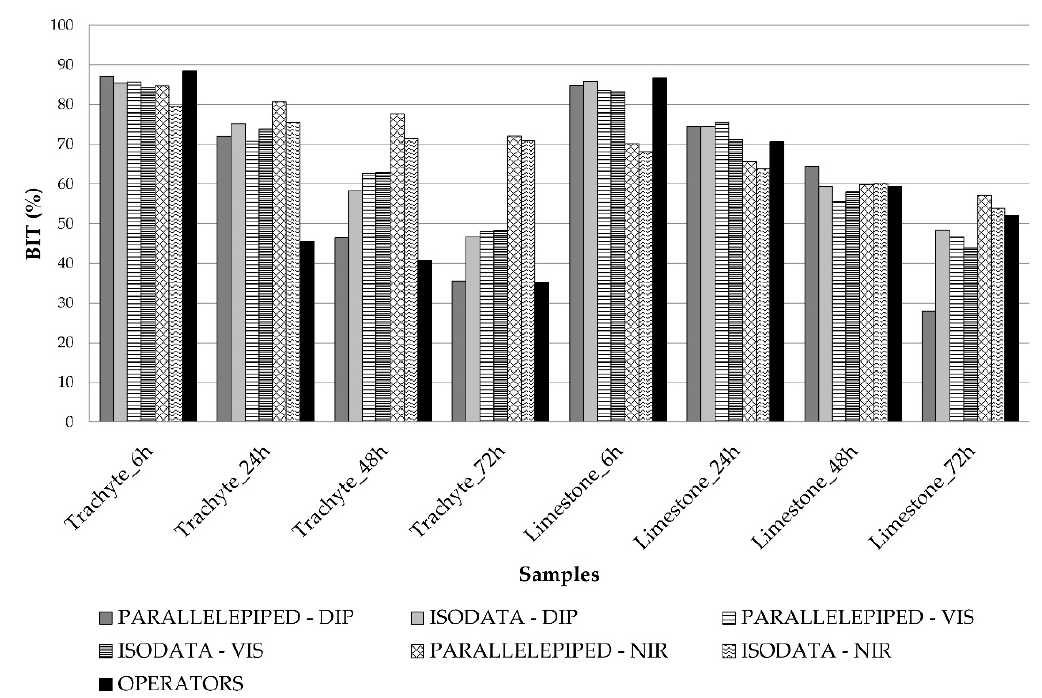
Figure 8. BIT values obtain by different techniques for each HMA and test step.